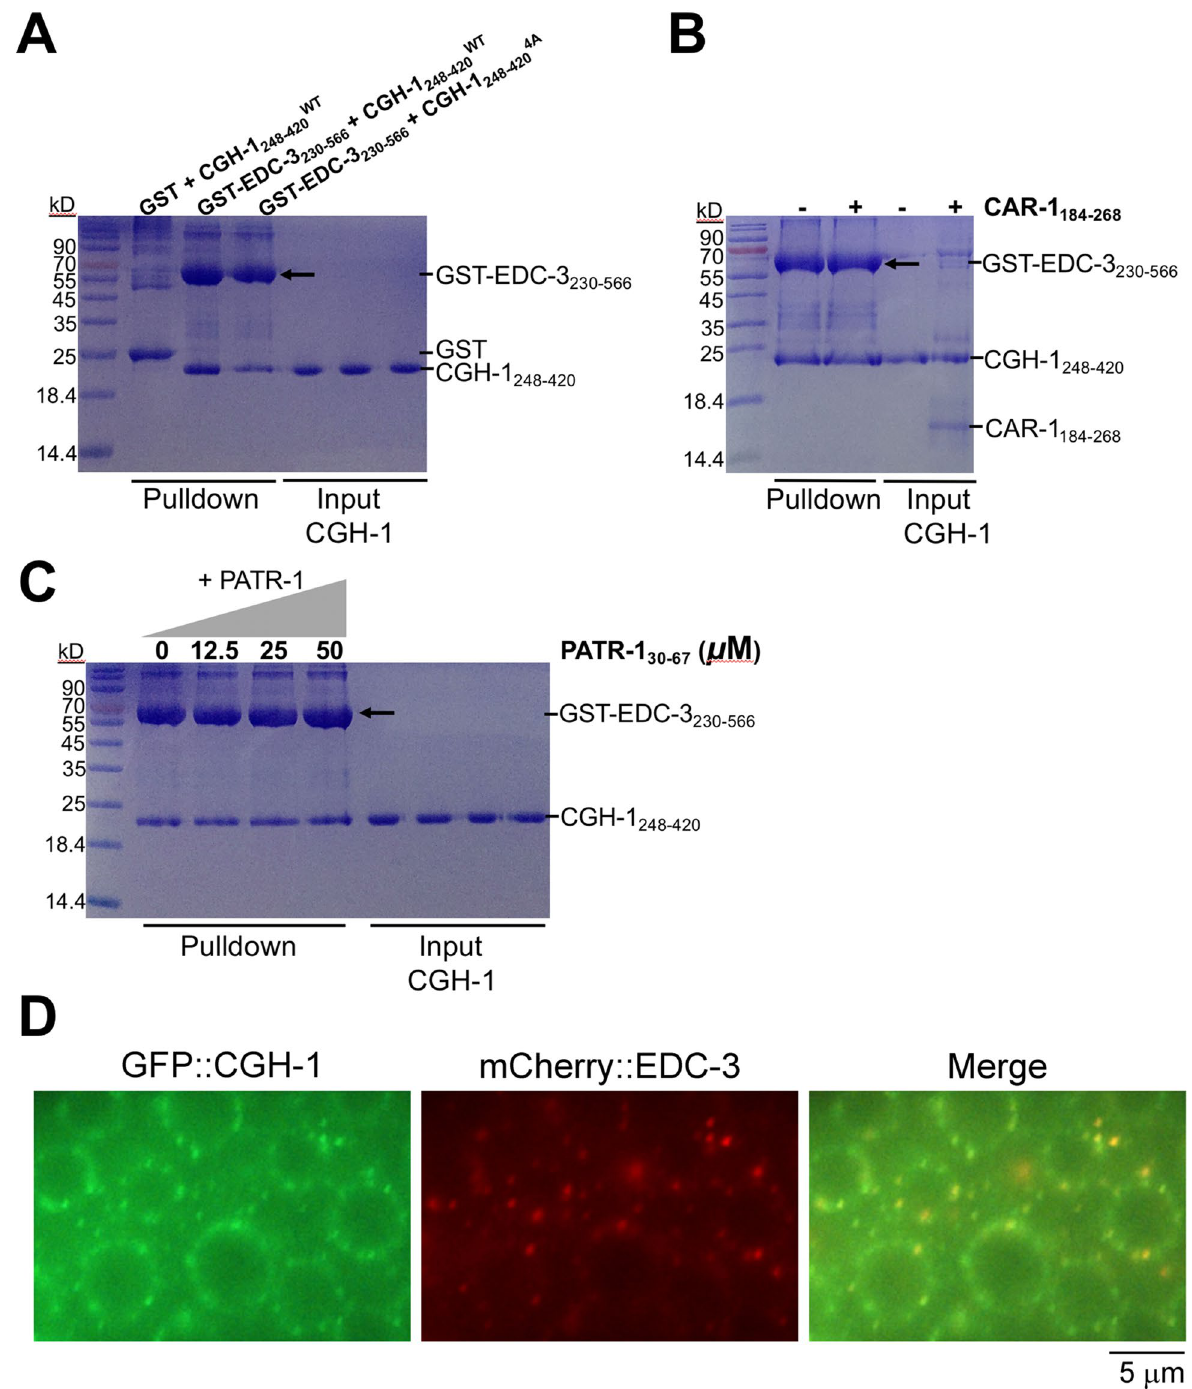
Figure 4. In vitro and in vivo interaction between C. elegans CGH-1 and EDC-3. ( A ) GST-pulldown assays of in vitro interaction between GST-EDC-3 230–566 and CGH-1 248–420 (WT or 4A mutant). For clarity, only the input of CGH-1 proteins was shown in SDS-PAGE analysis. ( B ) GST-pulldown assays of GST-EDC-3 230–566 and CGH- 1 248–420 (WT) without or with co-incubation of recombinant CAR-1 184–268 protein. ( C ) GST-pulldown assays of GST-EDC-3 230–566 and CGH-1 248–420 (WT) without or with co-incubation of increased concentration (12.5, 25, 50 μM) of PATR-1 30–67 peptide. Note: PATR-1 peptide is difficult to be seen in this SDS-PAGE analysis because of its small molecular weight. ( D ) Subcellular co-localization of GFP::CGH-1 and 3xFLAG::mCherry::EDC-3 in C. elegans . In adult germ cells, GFP::CGH-1 and 3xFLAG::mCherry::EDC-3 were concentrated in foci that were distributed in a perinuclear pattern around